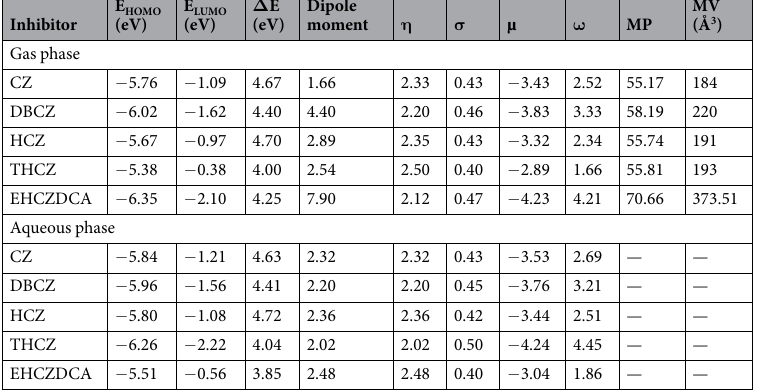
Table 8. Selected quantum chemical parameters for the studied